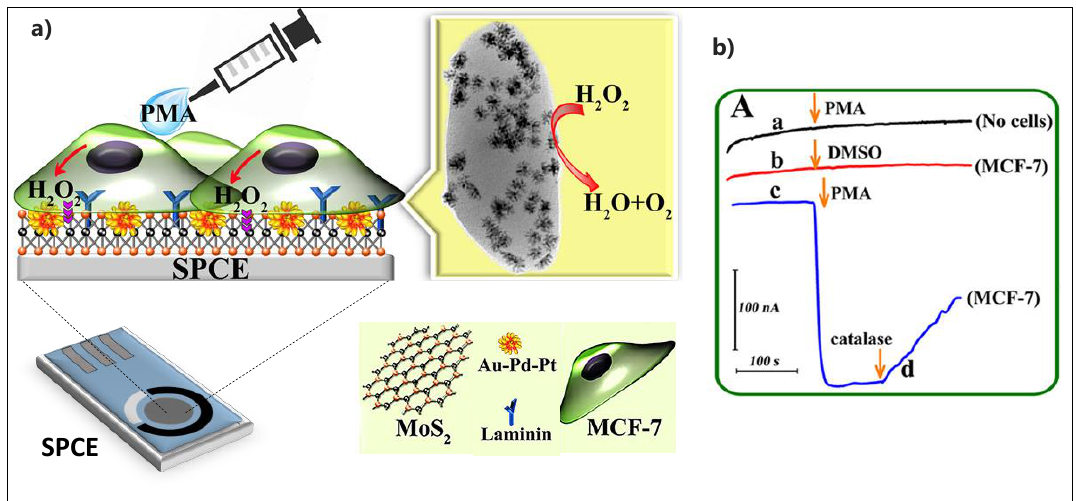
Figure11. ( a )Schematicdiagramforin-situscreeningofthereleasedH 2 O 2 fromMCF-7breastcancercell Figure 11. ( a ) Schematic diagram for in-situ screening of the released H 2 O 2 from MCF-7 breast cancer lines based on SPCE-modified Au − Pd − Pt / MoS 2 nanoflower-dispersed nanosheets; ( b ) Amperometric cell lines based on SPCE-modified Au−Pd−Pt/MoS 2 nanoflower-dispersed nanosheets; ( b ) response of the fabricated chemosensor to addition of PMA in the absence and presence of cultured Amperometric response of the fabricated chemosensor to addition of PMA in the absence and cells as well as DMSO as the control. Reproduced with permission from presence of cultured cells as well as DMSO as the control. Reproduced with permission from [165].